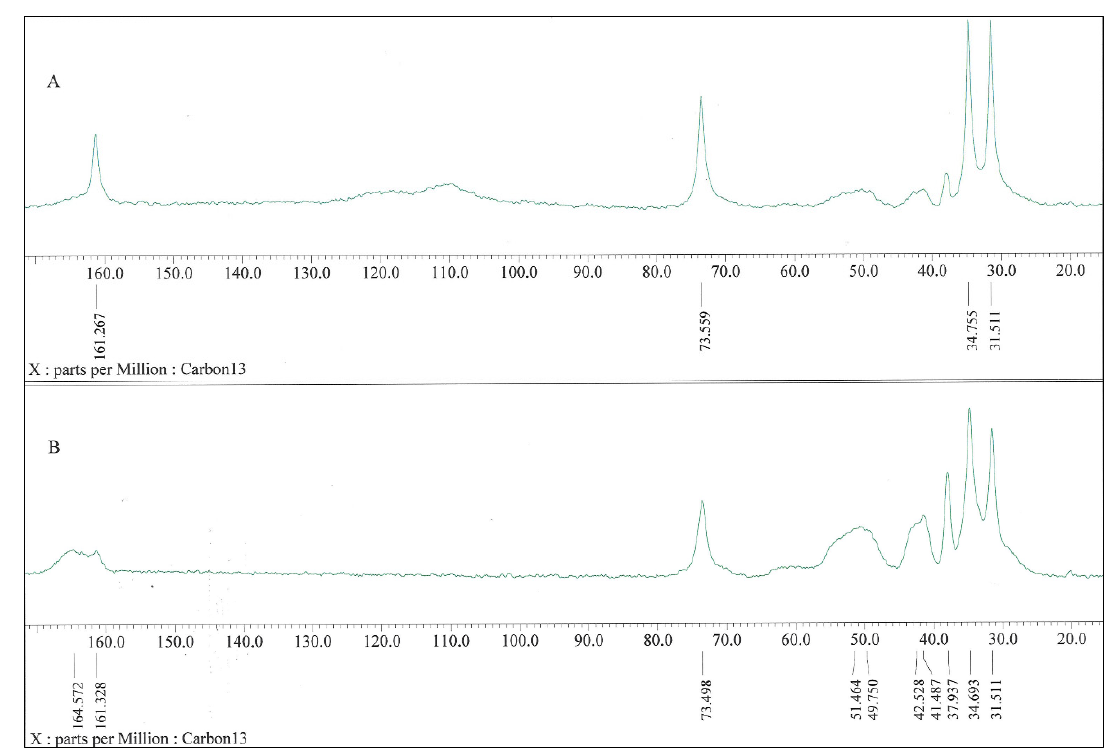
Figure 6. 13 C NMR spectrum measured in the solid-state: ( A ) single-pulse and ( B ) cross-polarization. The broad signal in the region 100–130 ppm in ( A ) is due to the Teflon spacers inserted into the spinner.